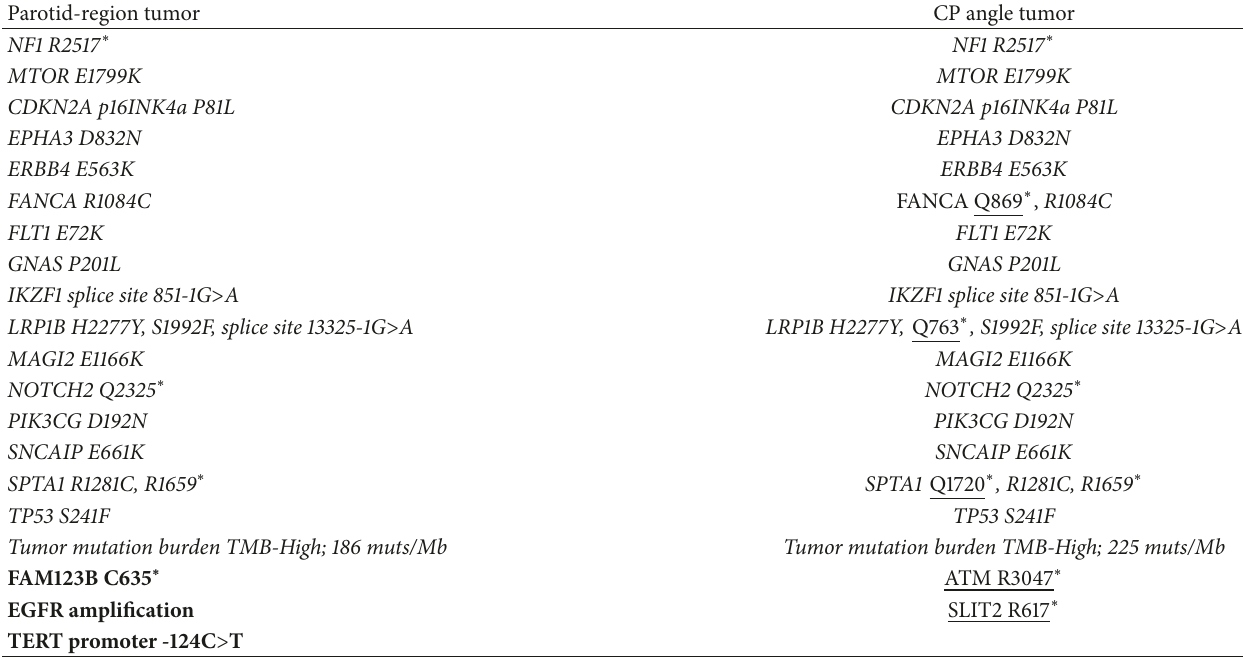
Table 1: Genomic alterations in the parotid-region and CP angle tumors.